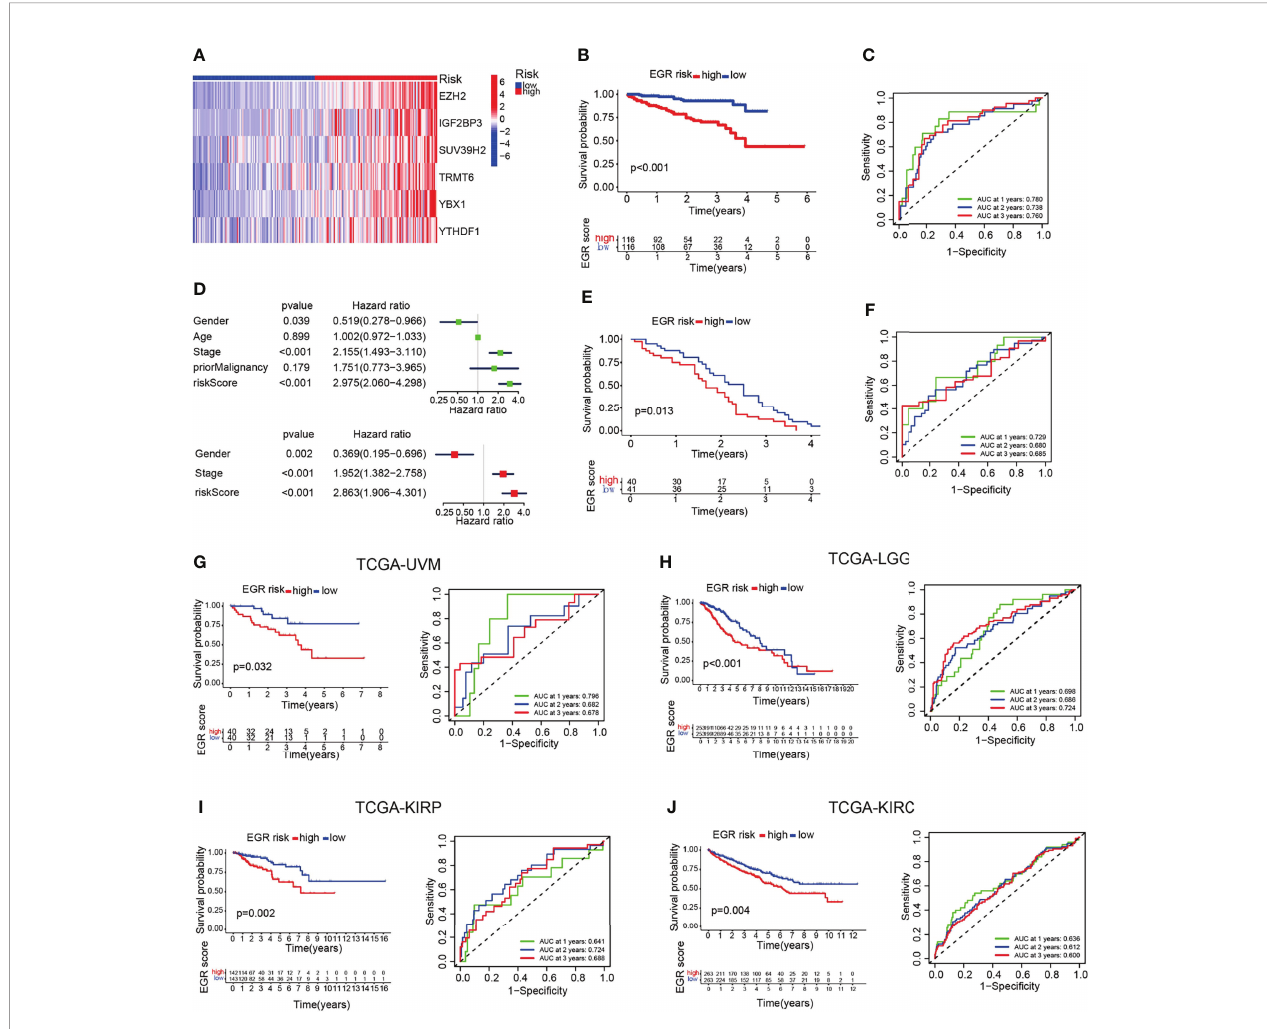
FIGURE 2 | EGRscore is associated with overall survival across multiple independent cohorts. (A) Heatmap of genes consisted in EGR signature in normal and HCC patients. (B) Kaplan – Meier curves for the OS of patients between the high- and low-risk groups in the ICGC-JP cohort. (C) Time-dependent ROC curves demonstrated the predictive ef fi ciency. (D) Univariate and multivariate Cox regression analyses for the EGRscore. (E) Kaplan – Meier curves for the OS of patients between the high- and low-risk groups in the GSE54236 cohort. (F) Time-dependent ROC curves demonstrated the predictive ef fi ciency in the GSE54236 cohort. (G) Kaplan – Meier survival analysis and time-dependent ROC curves based on EGRscore in the TCGA-UVM cohort. (H) Kaplan – Meier survival analysis and time- dependent ROC curves based on EGRscore in the TCGA-LGG cohort. (I) Kaplan – Meier survival analysis and time-dependent ROC curves based on EGRscore in the TCGA-KIRP cohort. (J) Kaplan – Meier survival analysis and time-dependent ROC curves based on EGRscore in the TCGA-KIRC